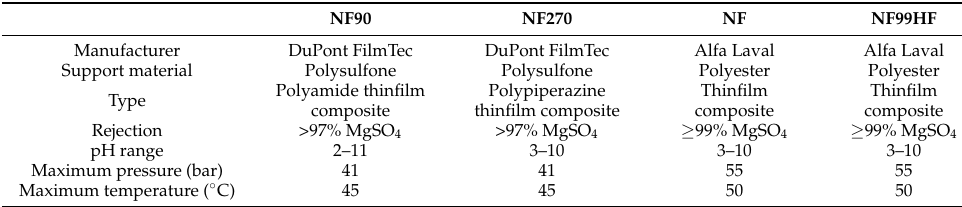
Table 2. Characteristics of the studied